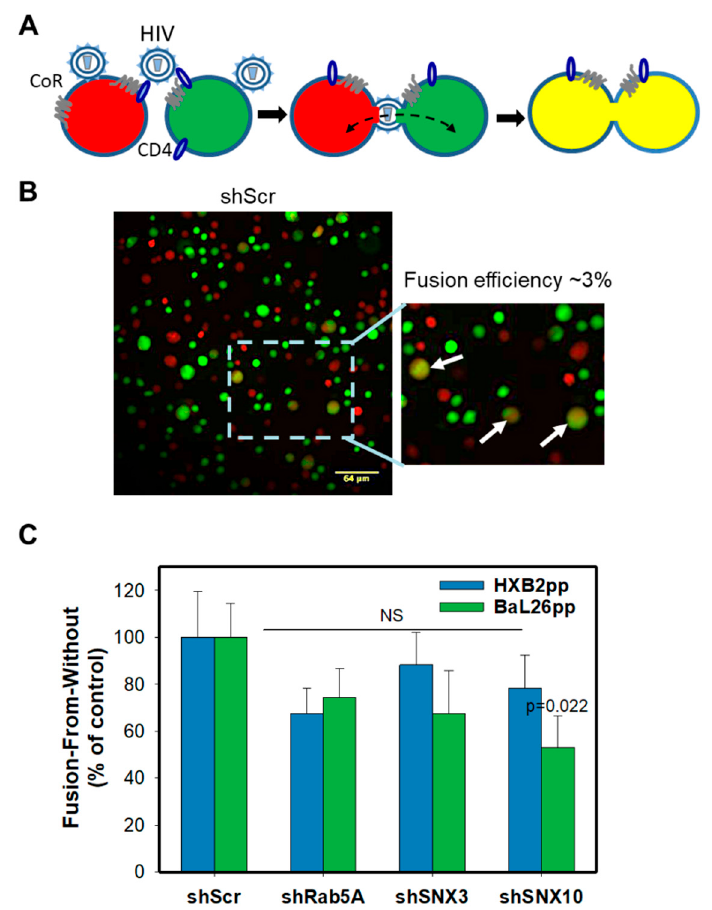
Figure 5. Effect of protein knockdown on HIV-1 mediated cell-cell fusion. ( A ) A depiction of the “fusion-from-without” (FFWO) assay that is based on detection of cell-cell fusion mediated by HIV-1 virions attached to adjacent cells. CoR, coreceptor. Cells are loaded with green (CMFDA) or orange/red (CMRA) cytoplasmic dyes and virus-mediated fusion between two adjacent cells is detected by appearance of double-labeled fusion products. ( B ) Representative images of fusion (FFWO) between scrambled shRNA-transduced CEM.CCR5 cells mediated by HXB2pp. Insert shows an enlarged view of the boxed area; the fused cells are marked by arrows. ( C ) Quantification of HXB2pp- and Bal26pp-mediated cell-cell fusion. The data points are mean and S.E. of 20 images from two independent